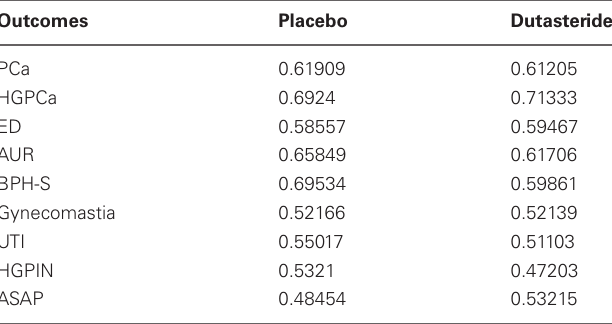
Table 4 | Nomogram concordance